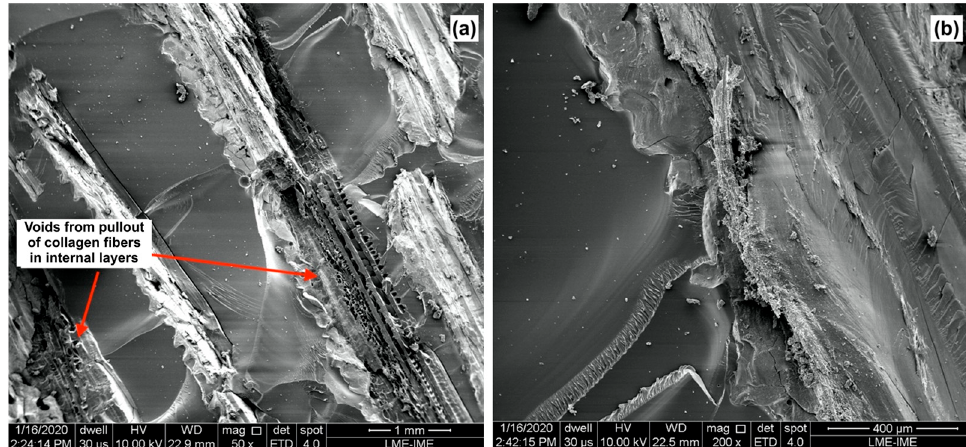
Figure 9. SEM image of the fracture surface of the 40 vol% of arapaima scales reinforced composite after the Izod test with 50 × ( a ) and 200 × magnification ( b ).